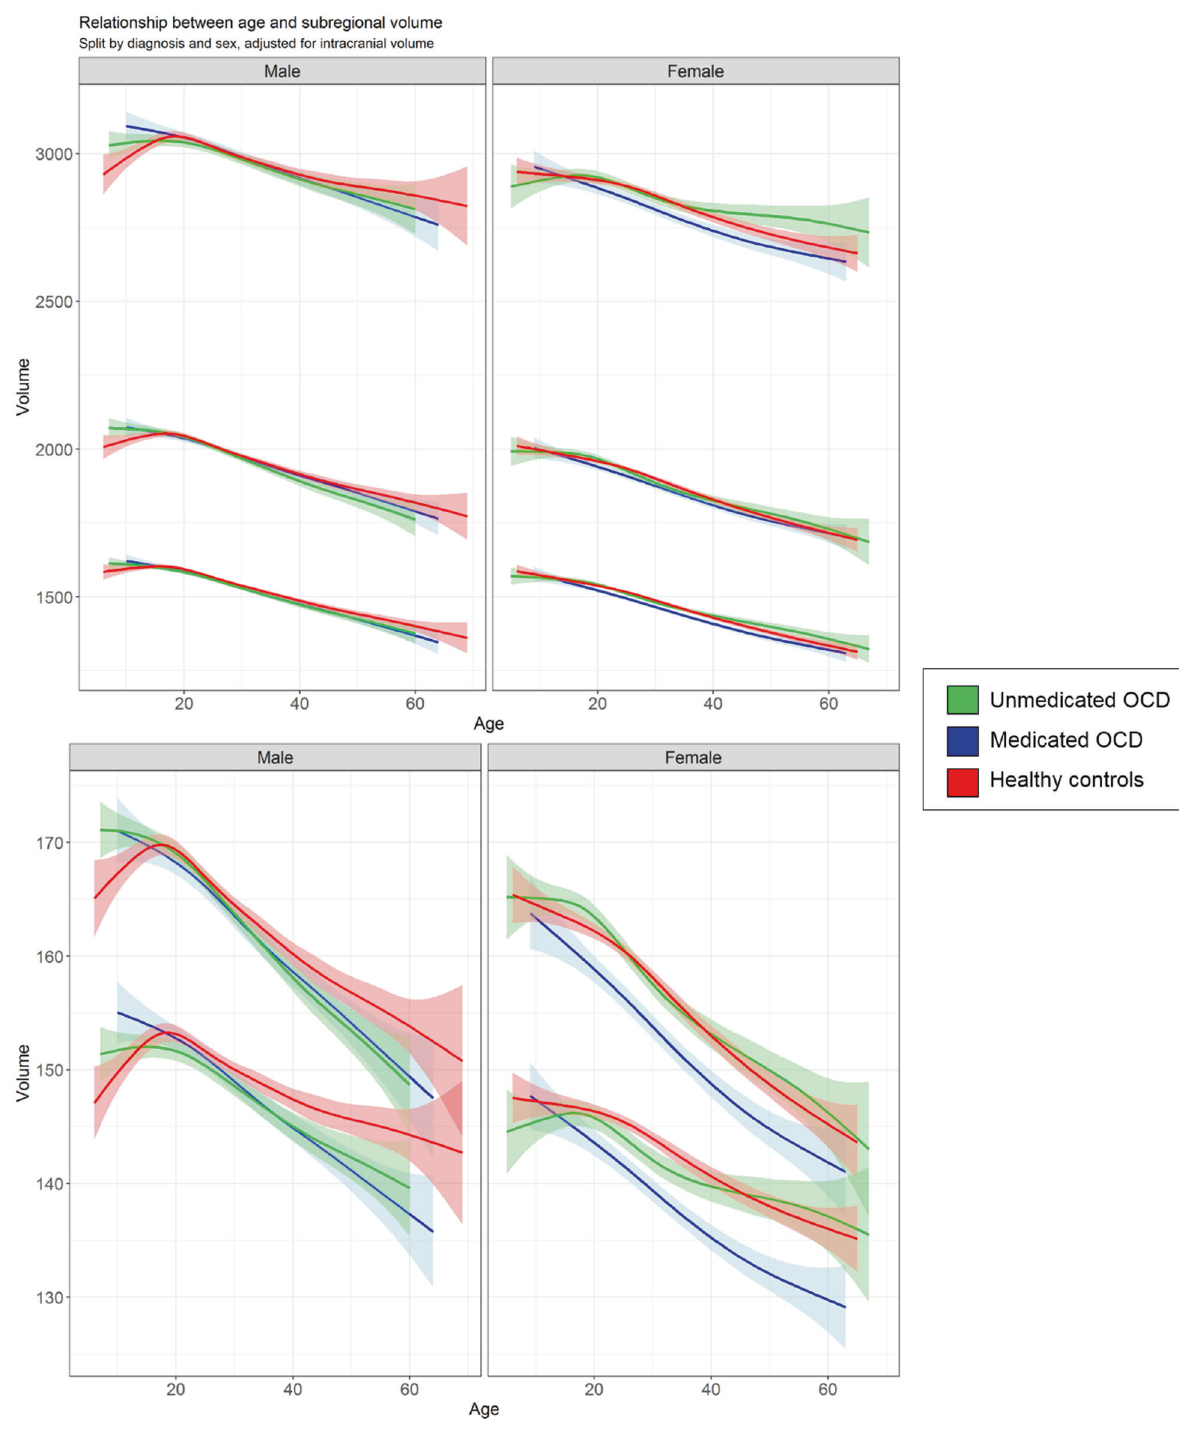
Fig. 3 Age trajectory of thalamus subregion volume for medicated obsessive-compulsive patients, unmedicated patients and healthy controls, split by sex and diagnosis. Adjusted for intracranial volume. Shading represents error margins. OCD obsessive-compulsive